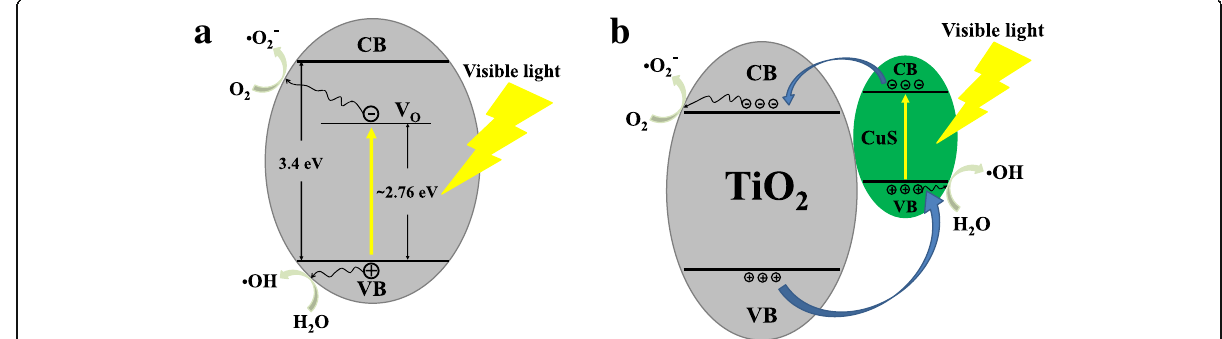
Fig. 8 Diagram of the separation and transmission process of photogenerated electron-hole in a TiO 2 /PVDF fiber and b CuS/TiO 2 /PVDF